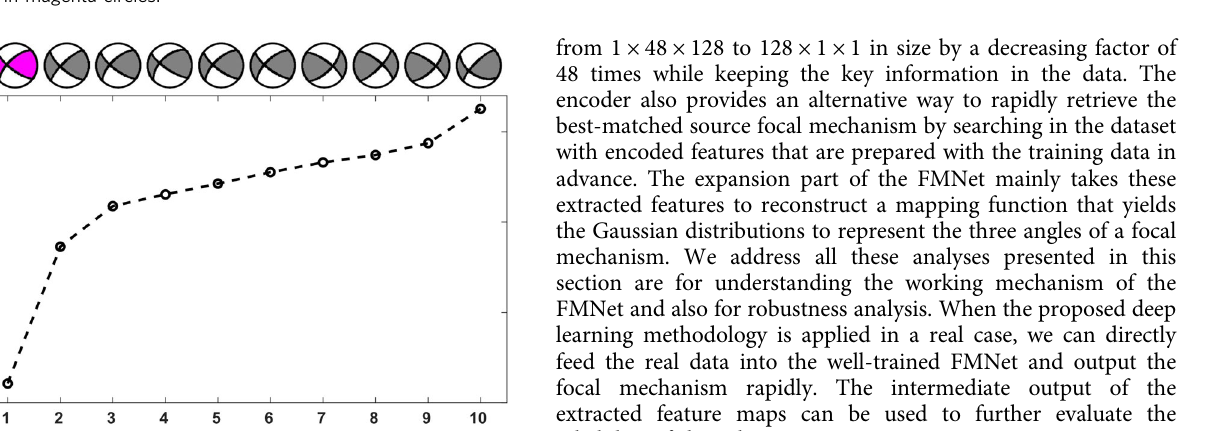
Fig. 4 Interpreting the neural network using the encoder. a The comparison of the L2-norm mis fi t distributions that are calculated in data domain (in red) and feature domain (in black) for the Mw 6.4 foreshock, which are ranked in ascending order. For clari fi cation, only the fi rst 5000 smallest mis fi ts are plotted. b – d The corresponding training labels represented in the discretized strike, dip, and rake angles, for the L2-norm mis fi t distribution in feature domain as shown in the black curve in ( a ). The best solutions of the strike, dip, and rake angles retrieved by fi nding the smallest L2-norm mis fi t are highlighted in magenta circles.